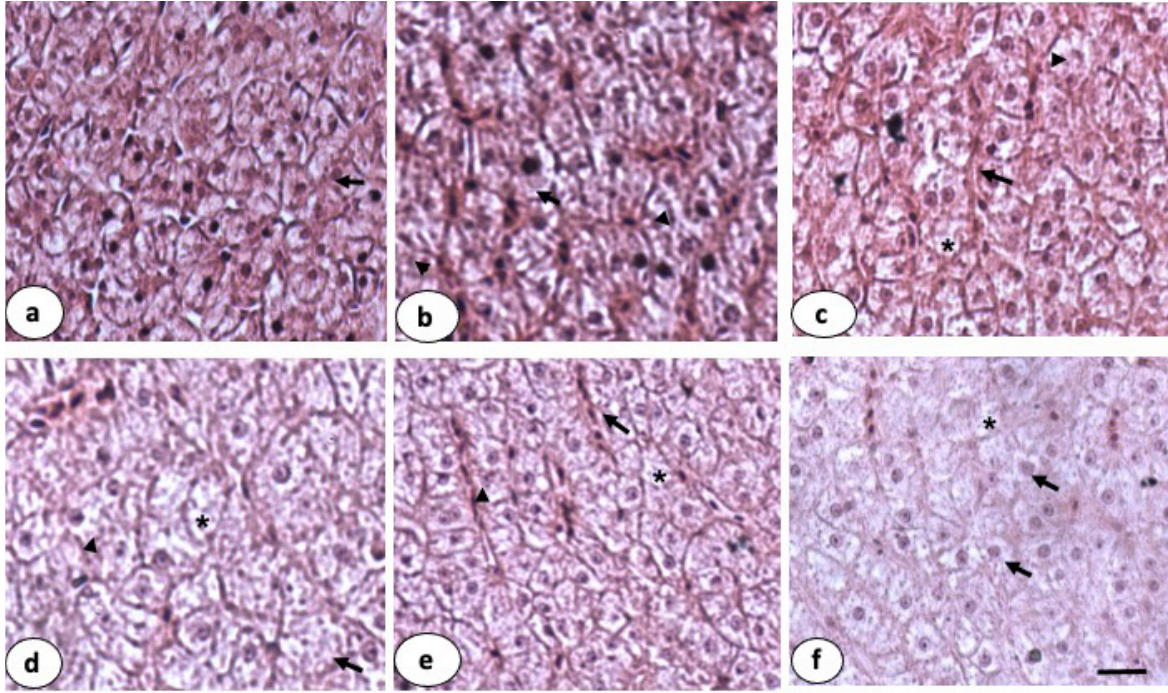
Figure 2. Liver tissue of Piaractus mesopotamicus exposed to Serjania erecta aqueous extract. a = sinusoidal congestion, peripheral cell nucleus (2.5 μg mL –1 ); b = hepatocyte hypertrophy, fatty degeneration (12.5 μg mL –1 ); c = leukocyte infiltrate, necrosis, vacuolization (25 μg mL –1 ); d = fatty degeneration, loss of cell boundary, necrosis (50 μg mL –1 ); e = sinusoidal congestion, vacuolization, inflammatory infiltrate (100 μg mL – 1 ); f = necrosis, loss of